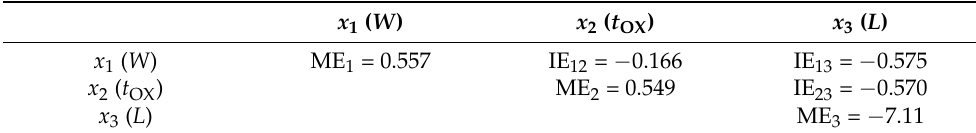
Table 4. f T main effects and interaction effects.